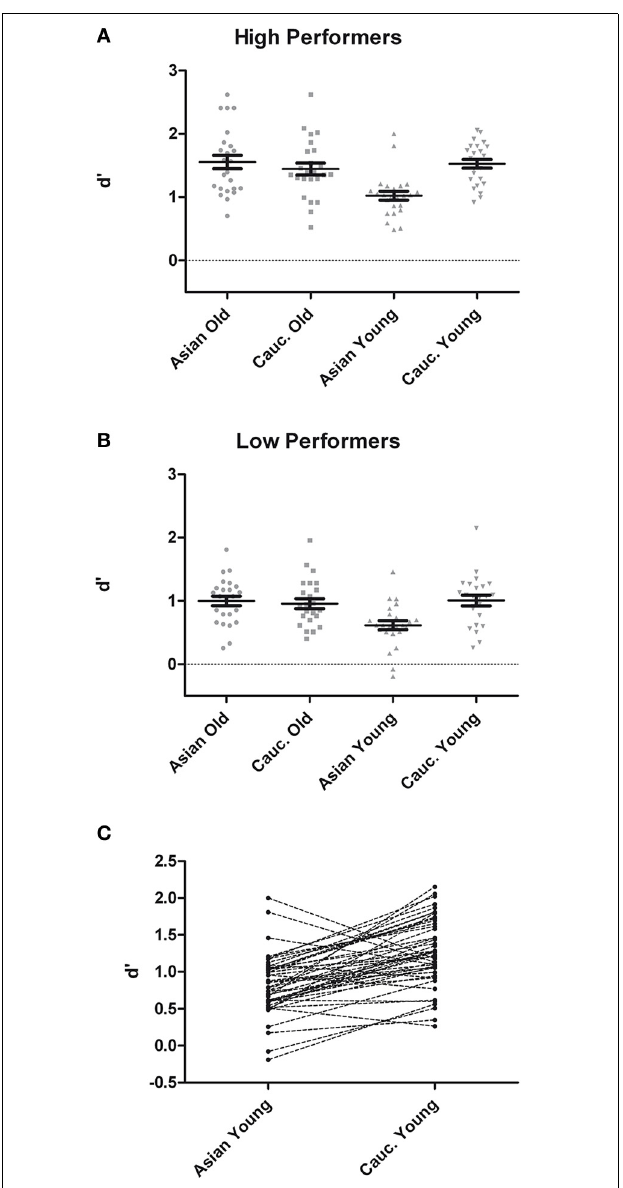
FIGURE 1 | Recognition memory performance measured in d ’ for high- (A) and low-performers (B) during test phases from the recognition memory experiment. (C) Pairwise differences in memory performance for young Asian vs. young Caucasian